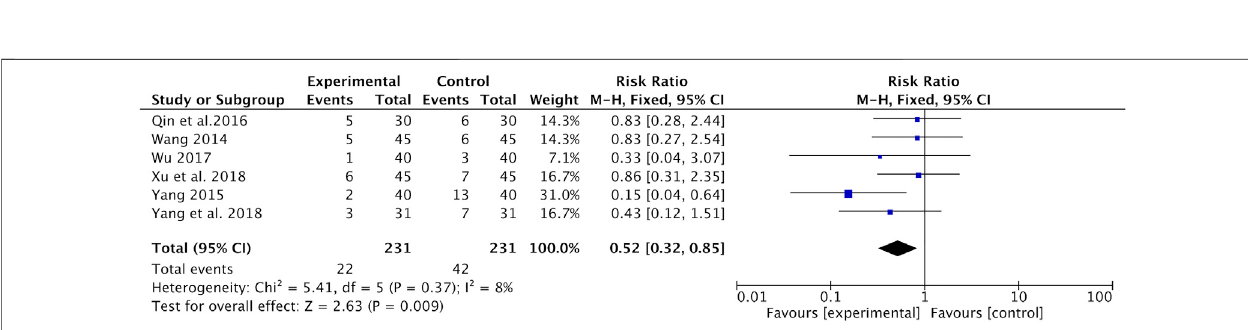
FIGURE 6 | Forest plot of hair loss of Astragalus-containing CHM combined with CT versus CT alone. CHM, Chinese herbal medicine; CT, chemotherapy.